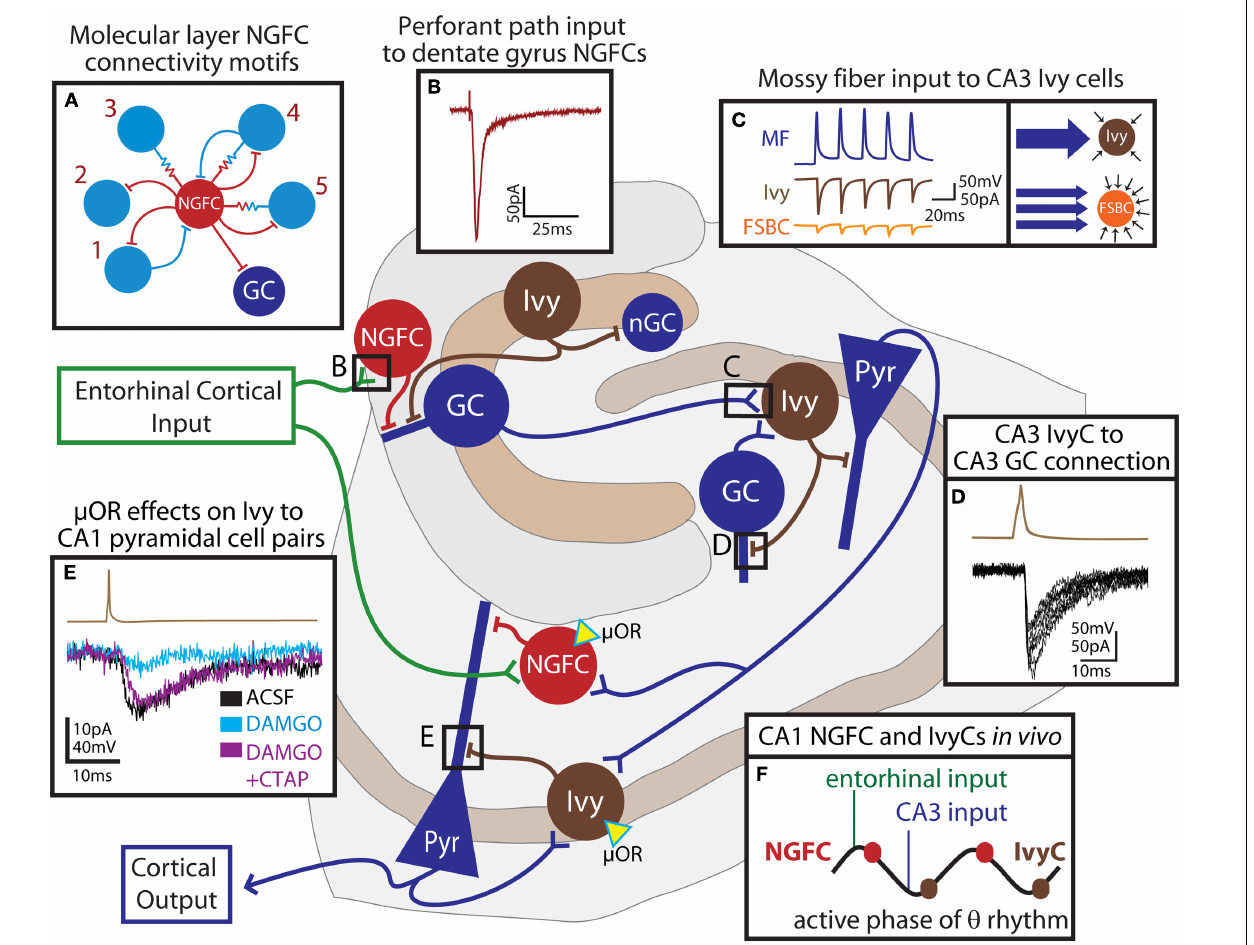
chemical synaptic). (B) shows the response in a dentate gyrus NGFC to perforant path stimulation. (C) illustrates that individual mossy fiber boutons (MF, blue trace) form strong unitary connections (left box) with postsynaptic Ivy cells in the CA3 (brown traces) while unitary connections between mossy fiber boutons and fast-spiking basket cells (FSBC, orange traces) are smaller in amplitude. However (right box), while Ivy cells receive relatively fewer individual connections from mossy fibers, FSBCs receive more frequent mossy fiber bouton input. (D) demonstrates, in a paired recording, that Ivy cells (action potential, brown trace) provide inhibition to CA3 GCs (IPSCs, black traces). (E) shows the effect of the μ -opioid receptor agonist, DAMGO on an Ivy cell (brown trace) to CA1 pyramidal cell (lower traces) pair.The paired connection (control ACSF, black) is nearly abolished by application of DAMGO (light blue), and can be restored by addition of the μ -opioid receptor antagonist, CTAP (DAMGO + CTAP, purple). (F) indicates the relative timing of NGFC and Ivy cell firing during theta rhythms recorded from the pyramidal cell layer in vivo . NGFCs tend to fire right after the peak of theta, shortly following entorhinal input, while Ivy cells tend to fire right after the trough, shortly following CA3 input and just after the firing of CA1 cells. Reproduced and modified with permission from Armstrong et al. (2011) (A,B) ; Szabadics and Soltesz (2009) (C) ; Szabadics et al. (2010) (D) , and Krook-Magnuson et al. (2011) (E)